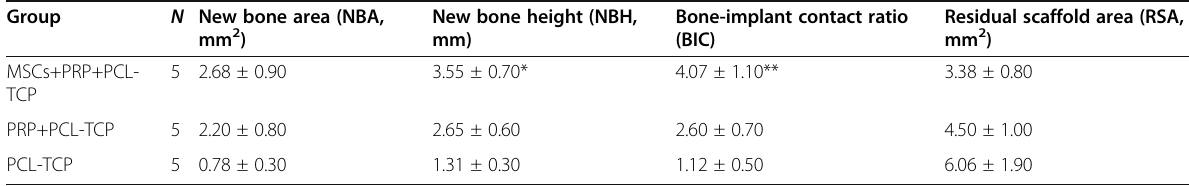
Table 2 Histomorphometric analysis